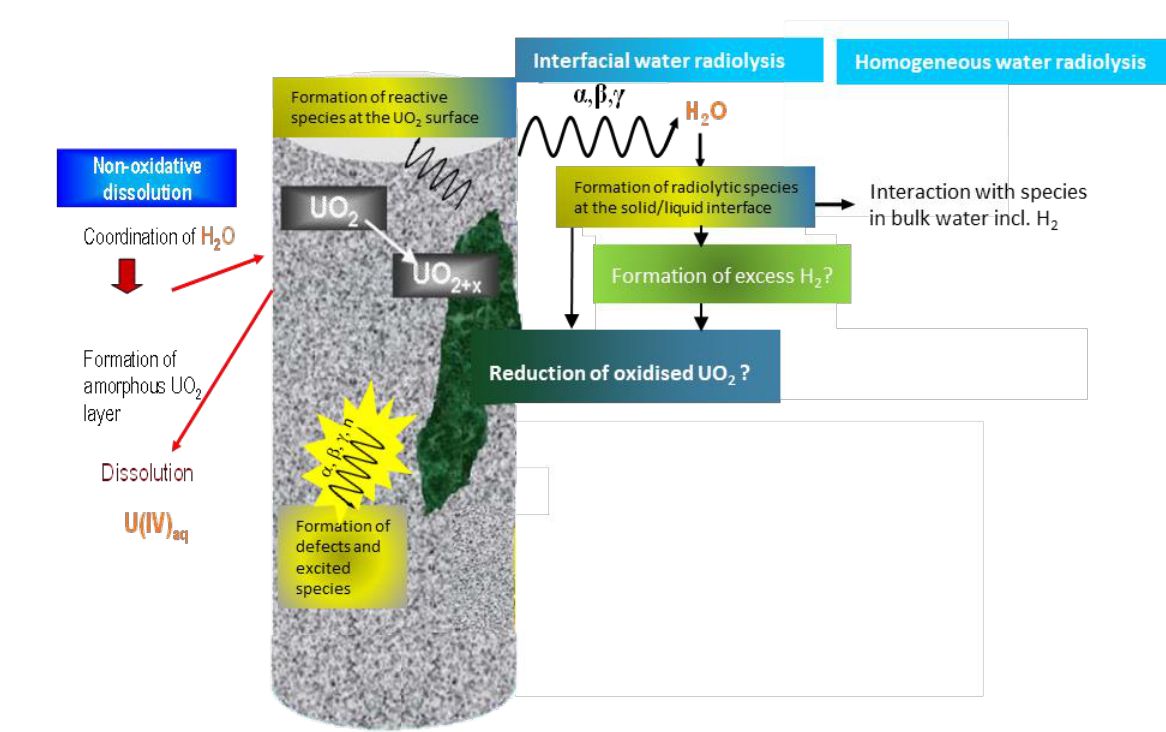
Figure 5. Alternative conceptual model for spent fuel – water interaction, modified from Riba et al. [30].